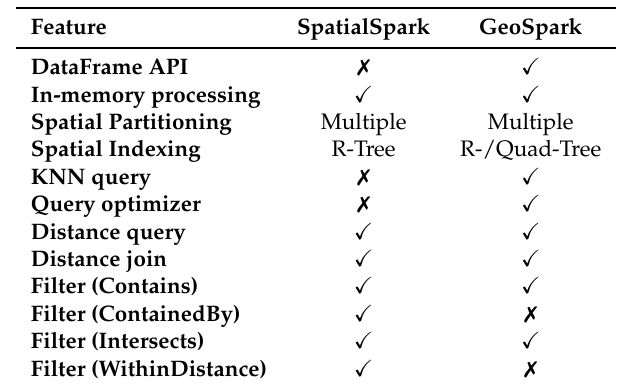
Table 5. Comparison of Spark-based spatial big data processing